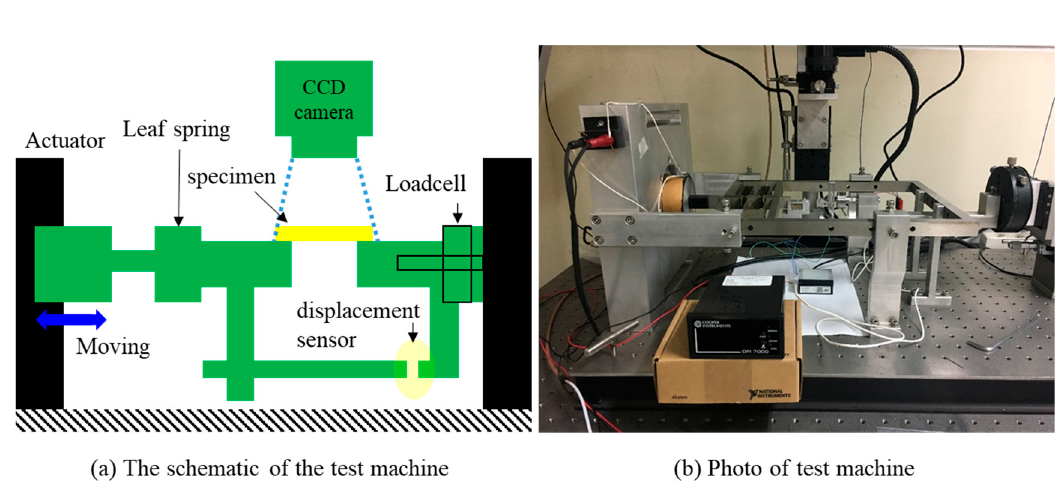
Figure 6. The fracture images of specimen when alignment is correct. 3. Tensile and Fatigue Test 3.1. Tensile Test and Mechanical Properties The mechanical properties of the thin films, such as modulus of elasticity, yield strength and tensile strength, can be obtained from the stress-strain curve. To compare the mechanical properties of the copper thin film according to process method, we performed a repetitive test five times or more under the same conditions on each of the rolled copper and the electrodeposited copper specimens. In this test, the tensile rate was fixed at 50 μ m/min (0.84 μ m/s). The thin film specimen has limitations in using attached sensors such as extensometers. Therefore, in this paper, we use a capacitance displacement sensor for measuring the displacement during the tensile test. To obtain the tensile properties accurately, it has to be measured the displacement of the interesting range in the specimen (5000 μ m in Figure 1a). However, the capacitance displacement sensor can measure only the length of reduced section in the specimen (13,500 μ m in Figure 1a). Therefore, we use the finite element analysis method to calculate the ratio of reduced section and an interesting range as shown in Figure 7. In addition, the deformation of interesting range is yield by multiplying the measurement data and the ratio. Figure 8 shows the results of applying finite element analysis. The result of ratio is 0.635 [14].